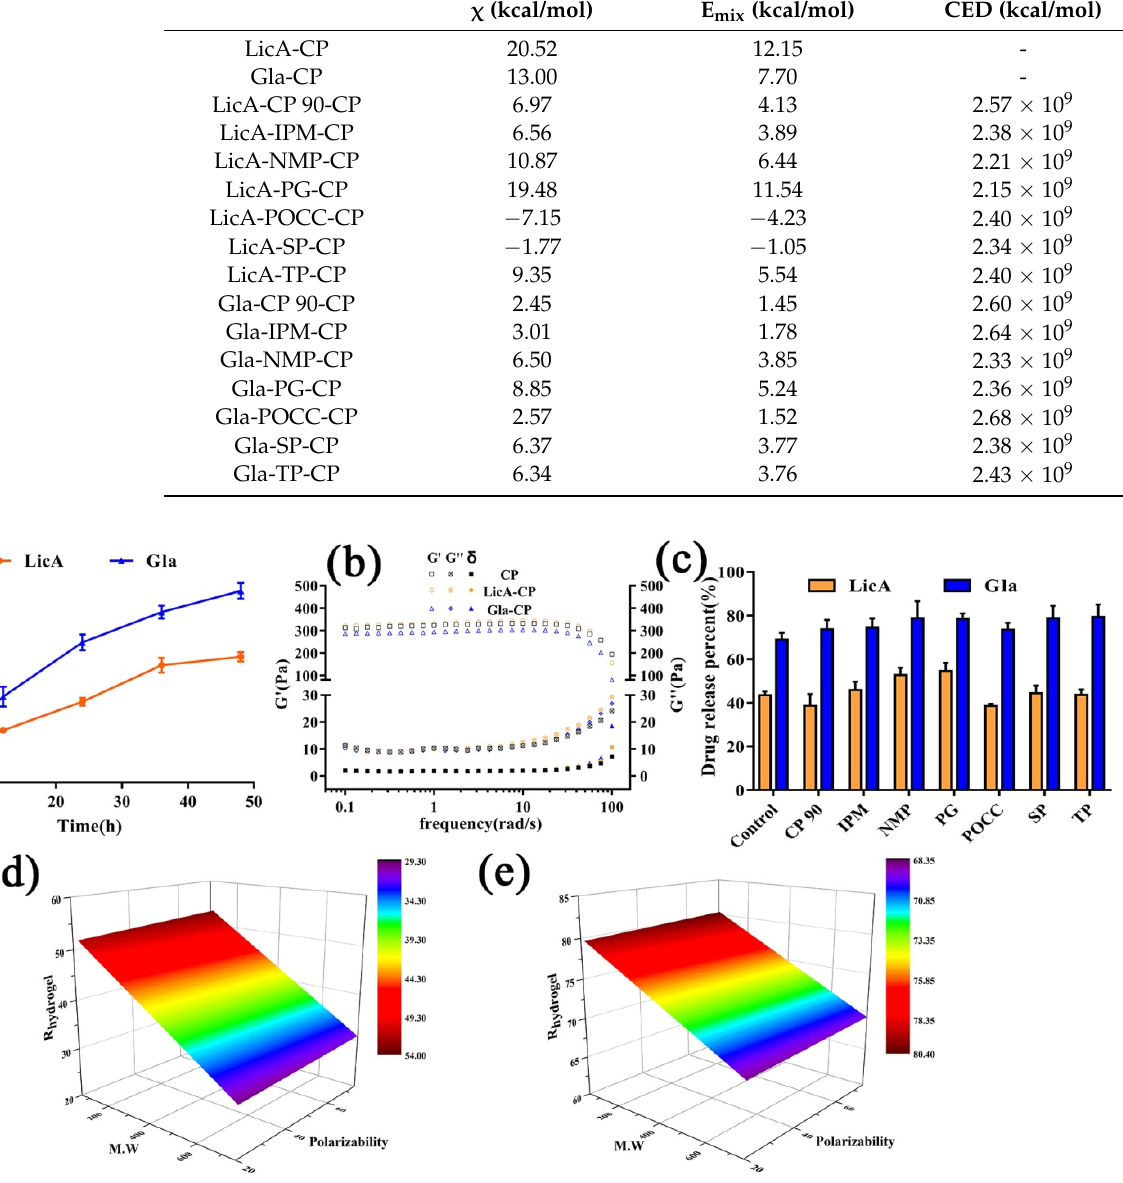
had no significant influence on the drug